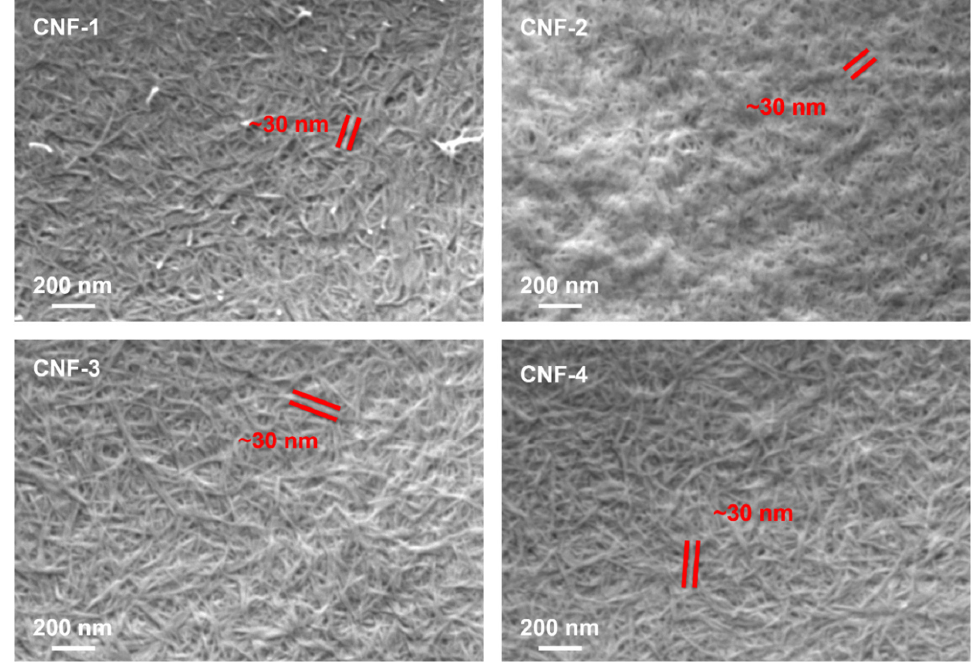
Figure 5. CNF membrane SEM images of the surface-exposed side during solvent casting. Red lines indicate typical thickness (~30 nm) of CNF fibers in corresponding membranes.